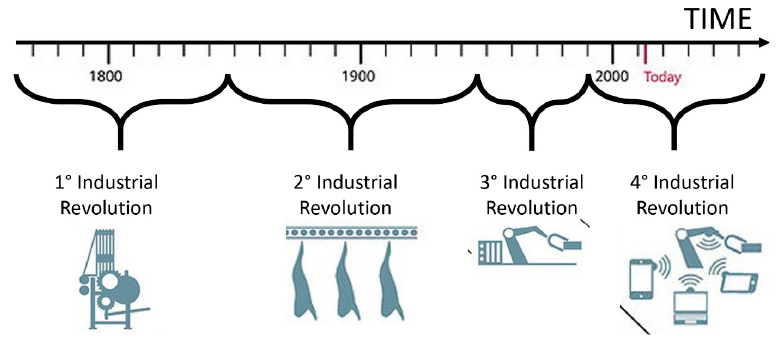
Figure 1. From Industry 1.0 to 4.0. Source: own elaboration.